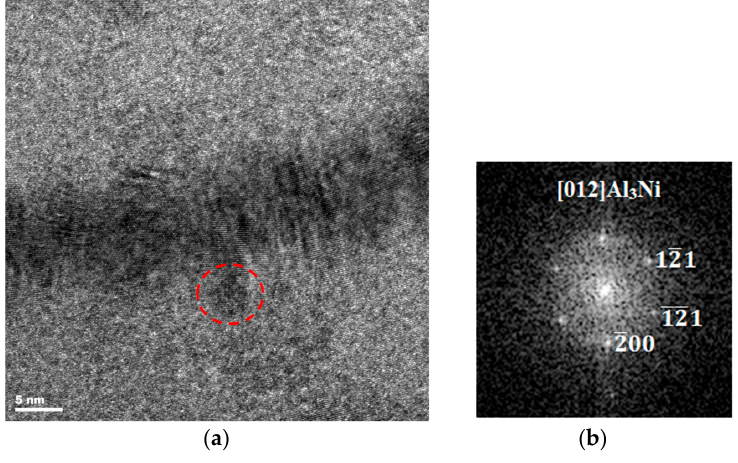
Figure 7. ( a ) HREM of a Ni/Al multilayer thin film, and ( b ) FFT of the grain marked in